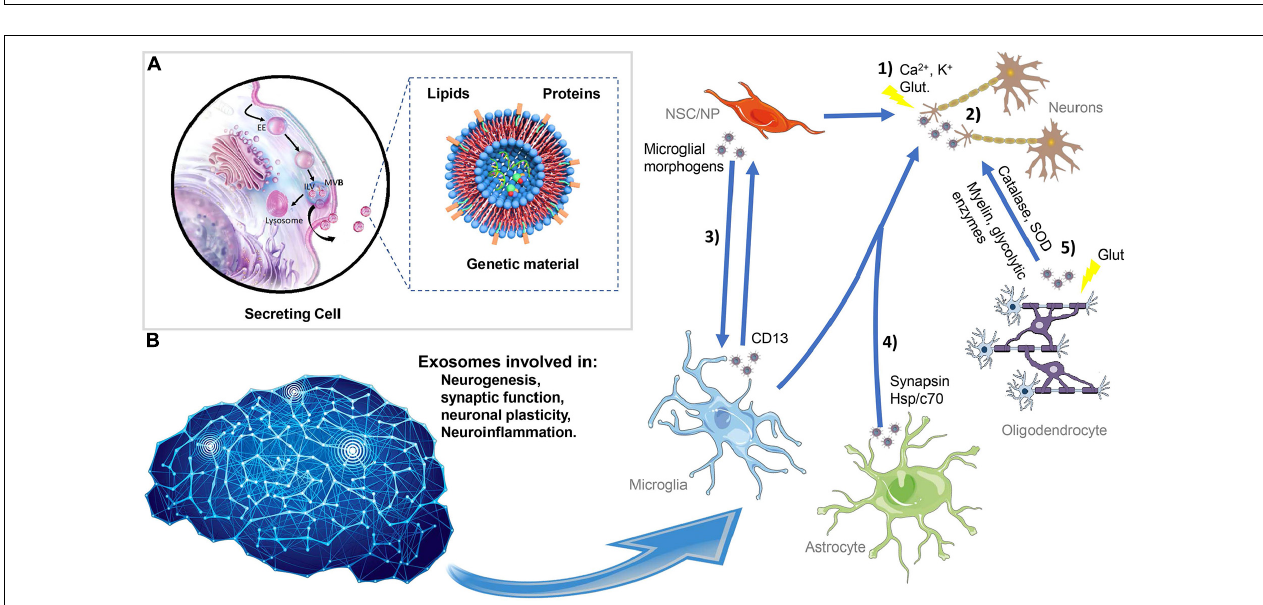
FIGURE 1 | Characterization of exosomes released from human neural stem cells differentiated from Huntington’s Disease iPS cells. (A) Left: Electron micrographs of exosomes released from neural stem cell membrane, scale 200 nm. Right: Exosome with a lipid bilayer membrane sizing 50 nm. (B) Nanoparticle Tracking Analysis (NTA) of exosomes with sizes ranging from 67.7 to 152.1 nm (10th; 90th percentile) cited from Lopes et al. (2020).